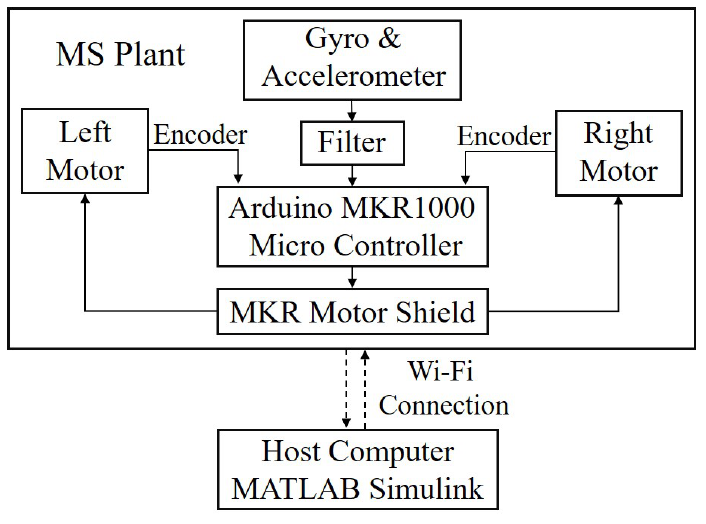
Figure 6. The MS system hardware